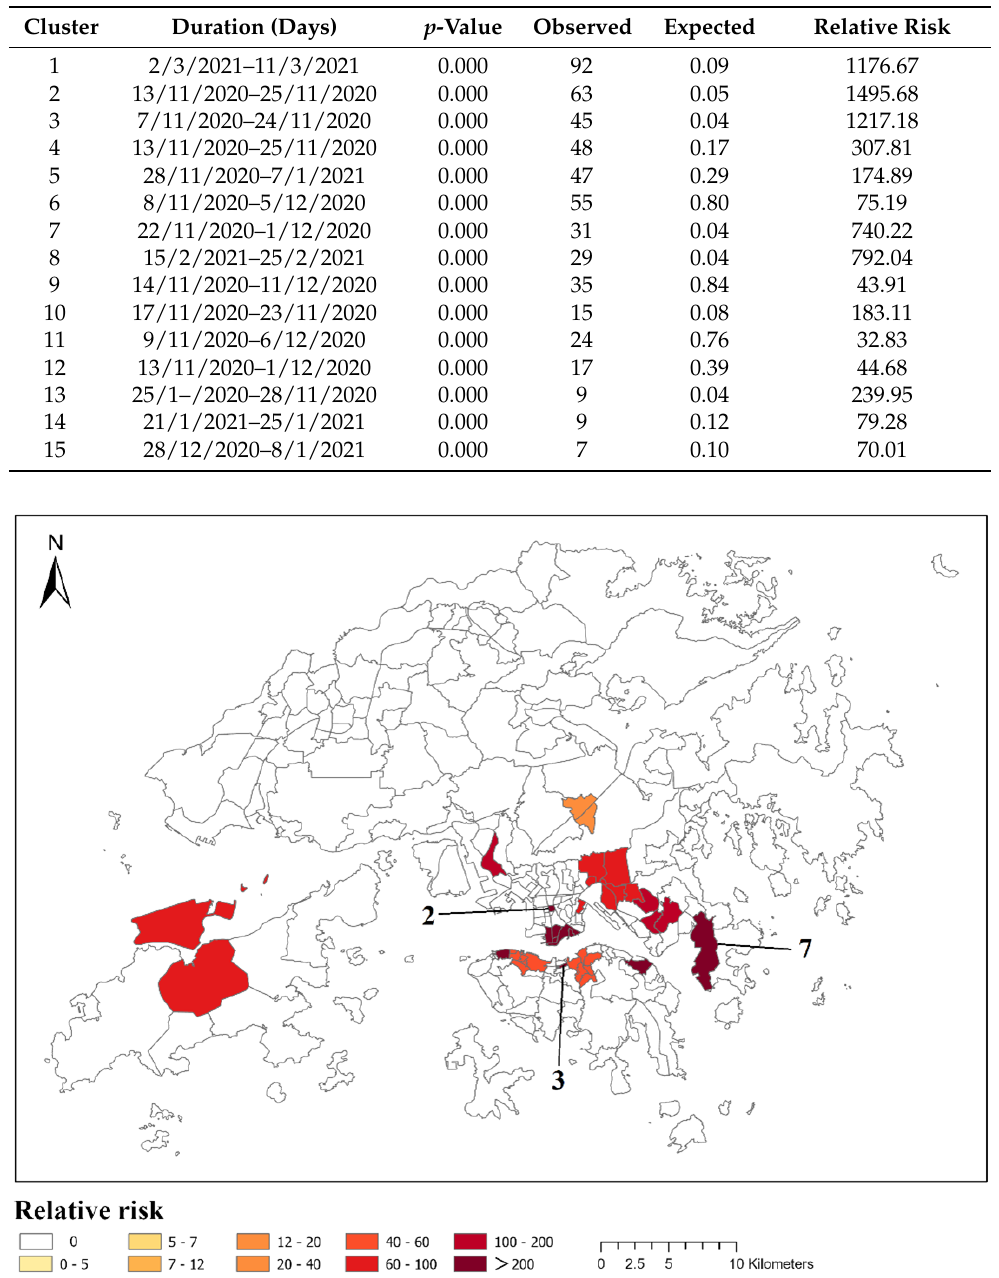
Figure 10. Space–time cluster distribution in stage III at non-residential locations (In which number 2, 3, 7 indicate the most significant clusters).